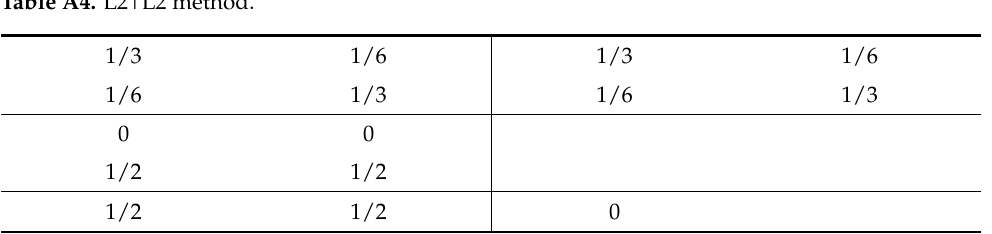
Table A4. L2|L2 method.